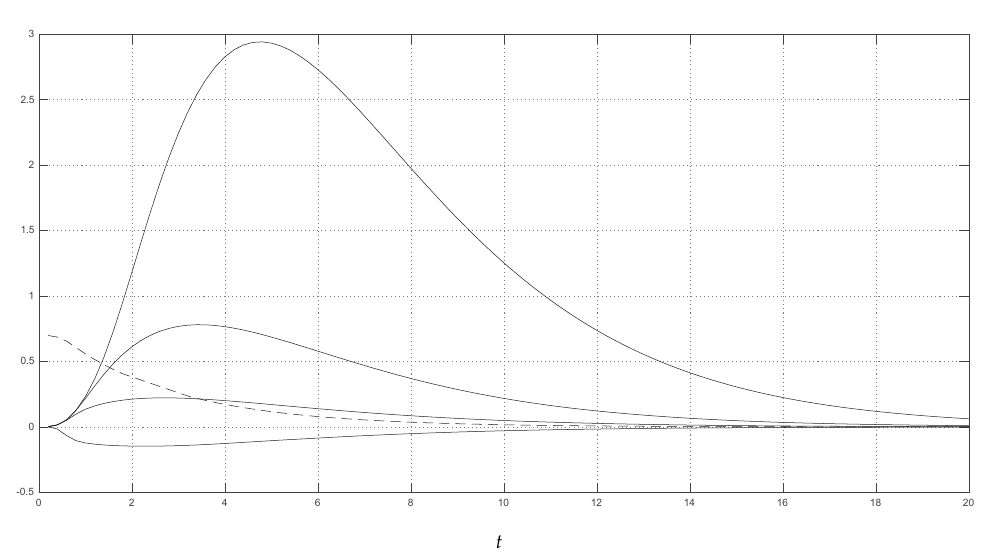
Figure 2. Geometric with ρ = 3/10 compound sum of independent Weibull with α = 3 random variables. Dashed curve: s.f. Continuous curve, from lowest to highest curve: approximate stabilities for perturbation points x = 1/2, 3/2, 3, 7,